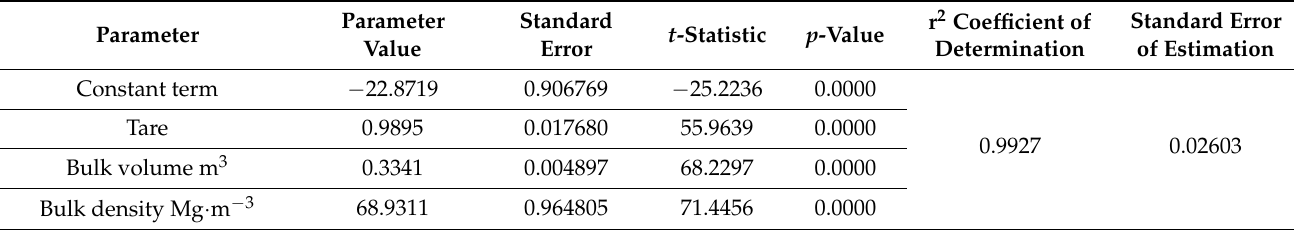
Table 5. Evaluation of model parameters on GVW for sawdust